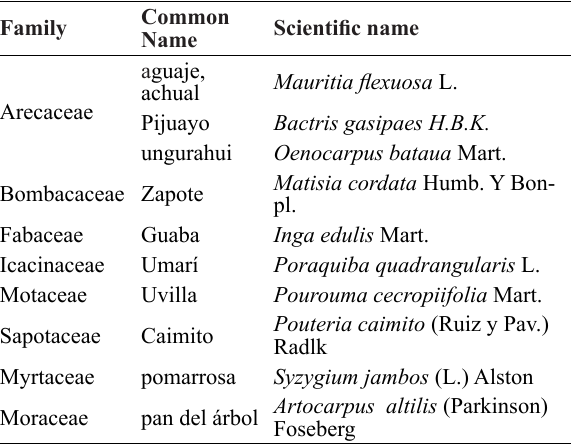
Table 9: List of Amazonian fruit trees with most frequency mentioned in Iquitos – Nauta road in Loreto